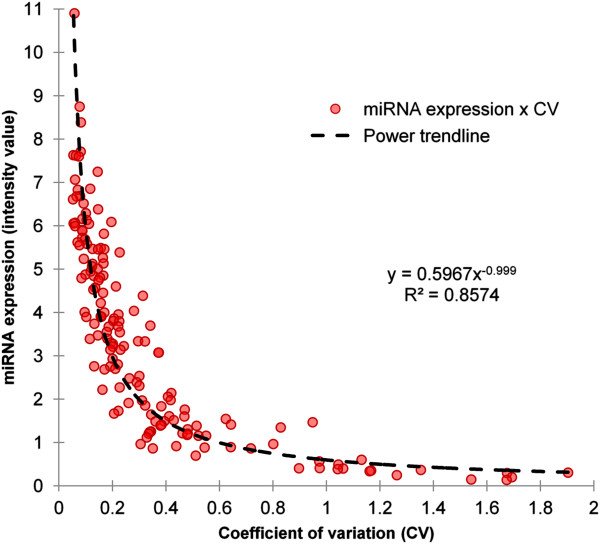
AT core miRNAs: miRNA average expression vs. coefficient of variation. Each circle represents one unique miRNA and the coordinates of X and Y axis are the respective values for average expression of the miRNA and its coefficient of variation from different samples. AT core miRNAs consist of miRNAs detected in the subcutaneous adipose tissue of all steers.